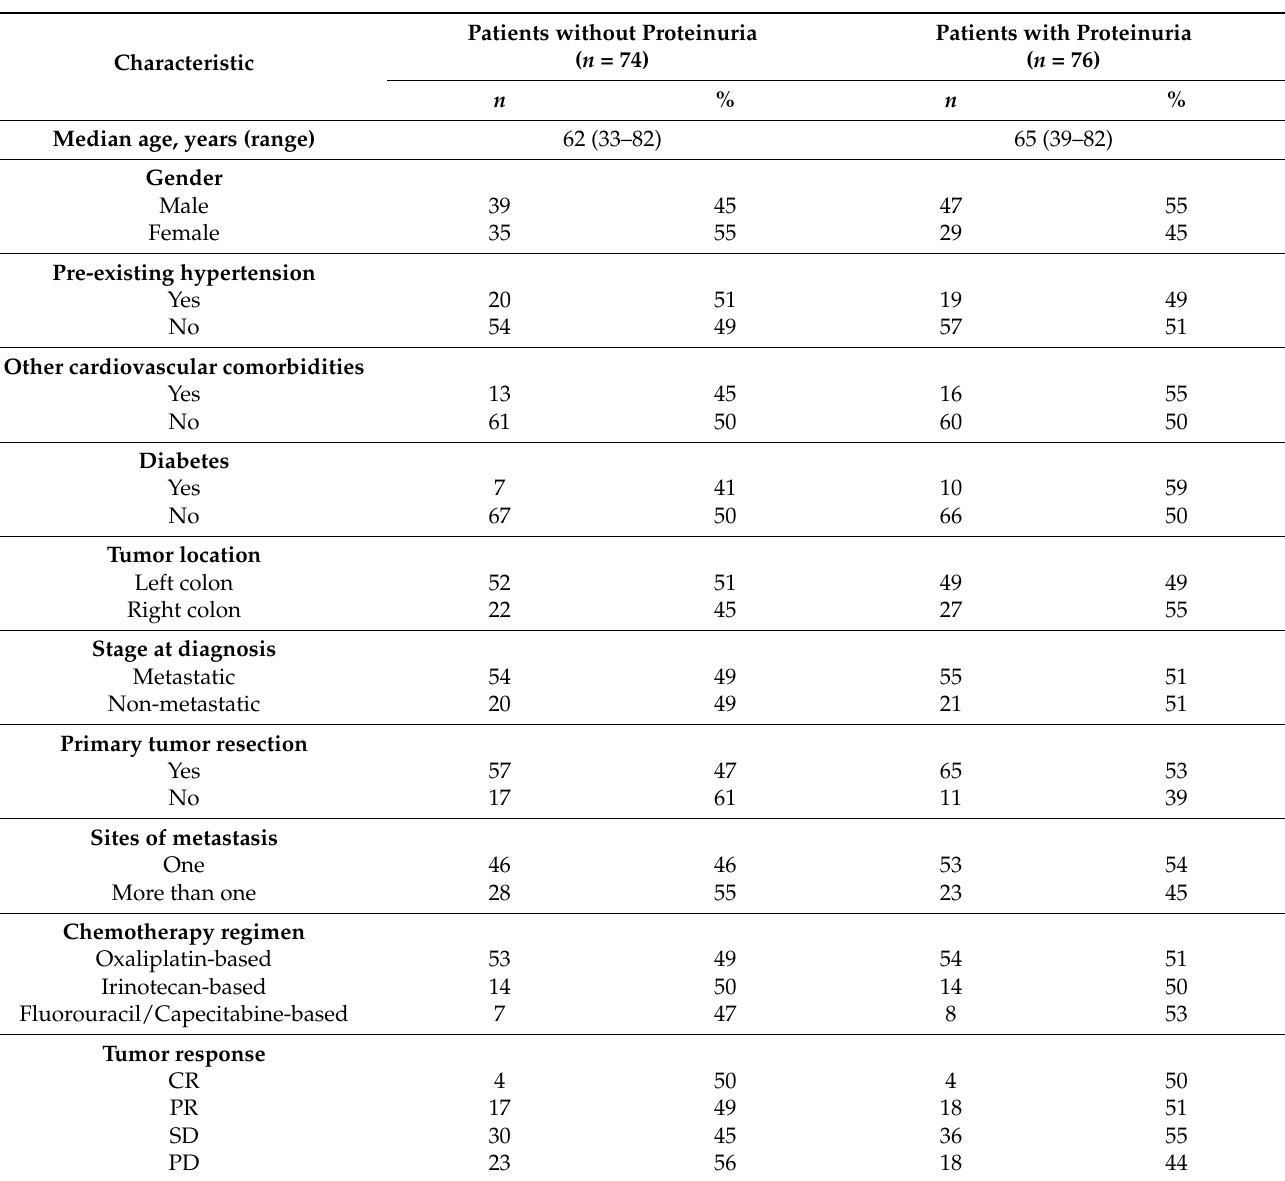
Table 1. Patients’